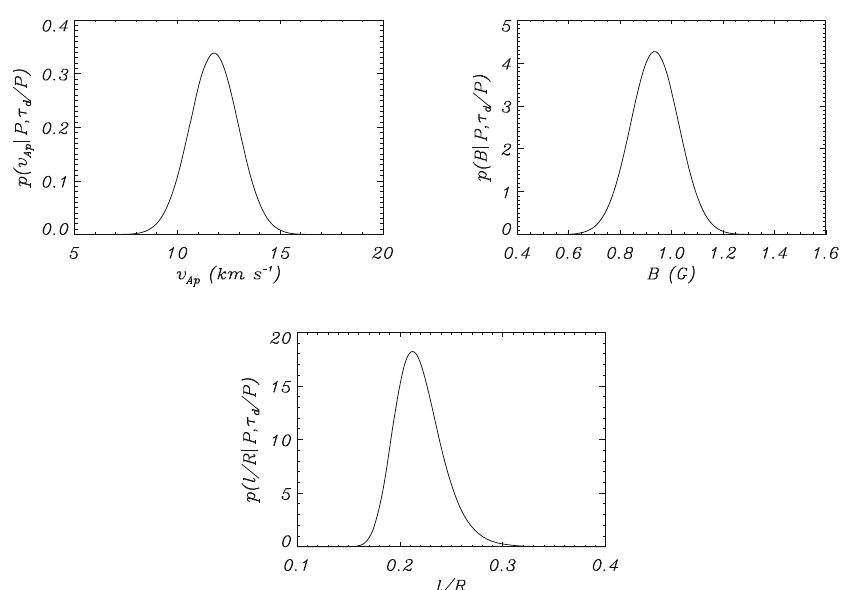
Fig. 93 Marginal posteriors for the filament Alfvén velocity ( v Ap ), magnetic field strength ( B ), and trans- verse inhomogeneity length-scale of the plasma density ( l / R ) for a thread oscillation with P = 3 min, τ = 9 min and a wavelength λ = 3000 km (see, e.g., Lin et al. 2007). This inversion assumes a coronal d density ρ c = 2 . 5 × 10 − 13 kgm − 3 and10%relative errorsinthe measured period,wavelength and damping time.Fortheinferredparameters,themediananderrorsandthe68%credibleregionare: v Ap = 11 . 80 l / R = 0 . 22 + 0 . 03 − B = 0 . 93 + 0 . 10 − 0 . 09 ; and 0 . 02 (adapted from Arregui et al.